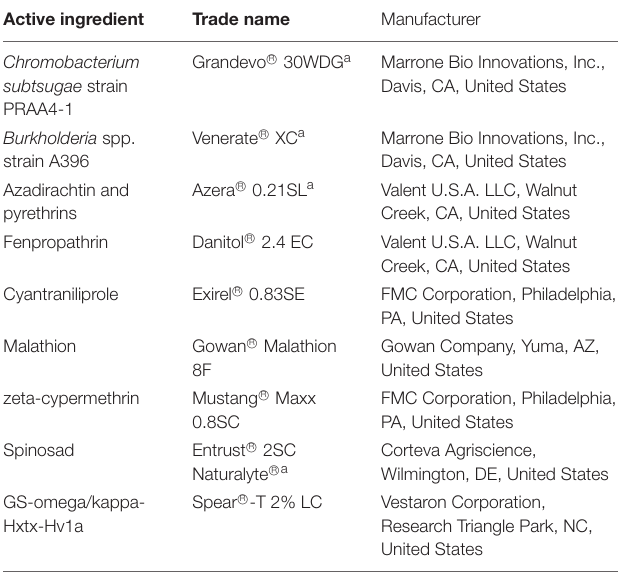
TABLE 1 | List of active ingredients, trade name, manufacturer of insecticide formulations used in this study. Active ingredient